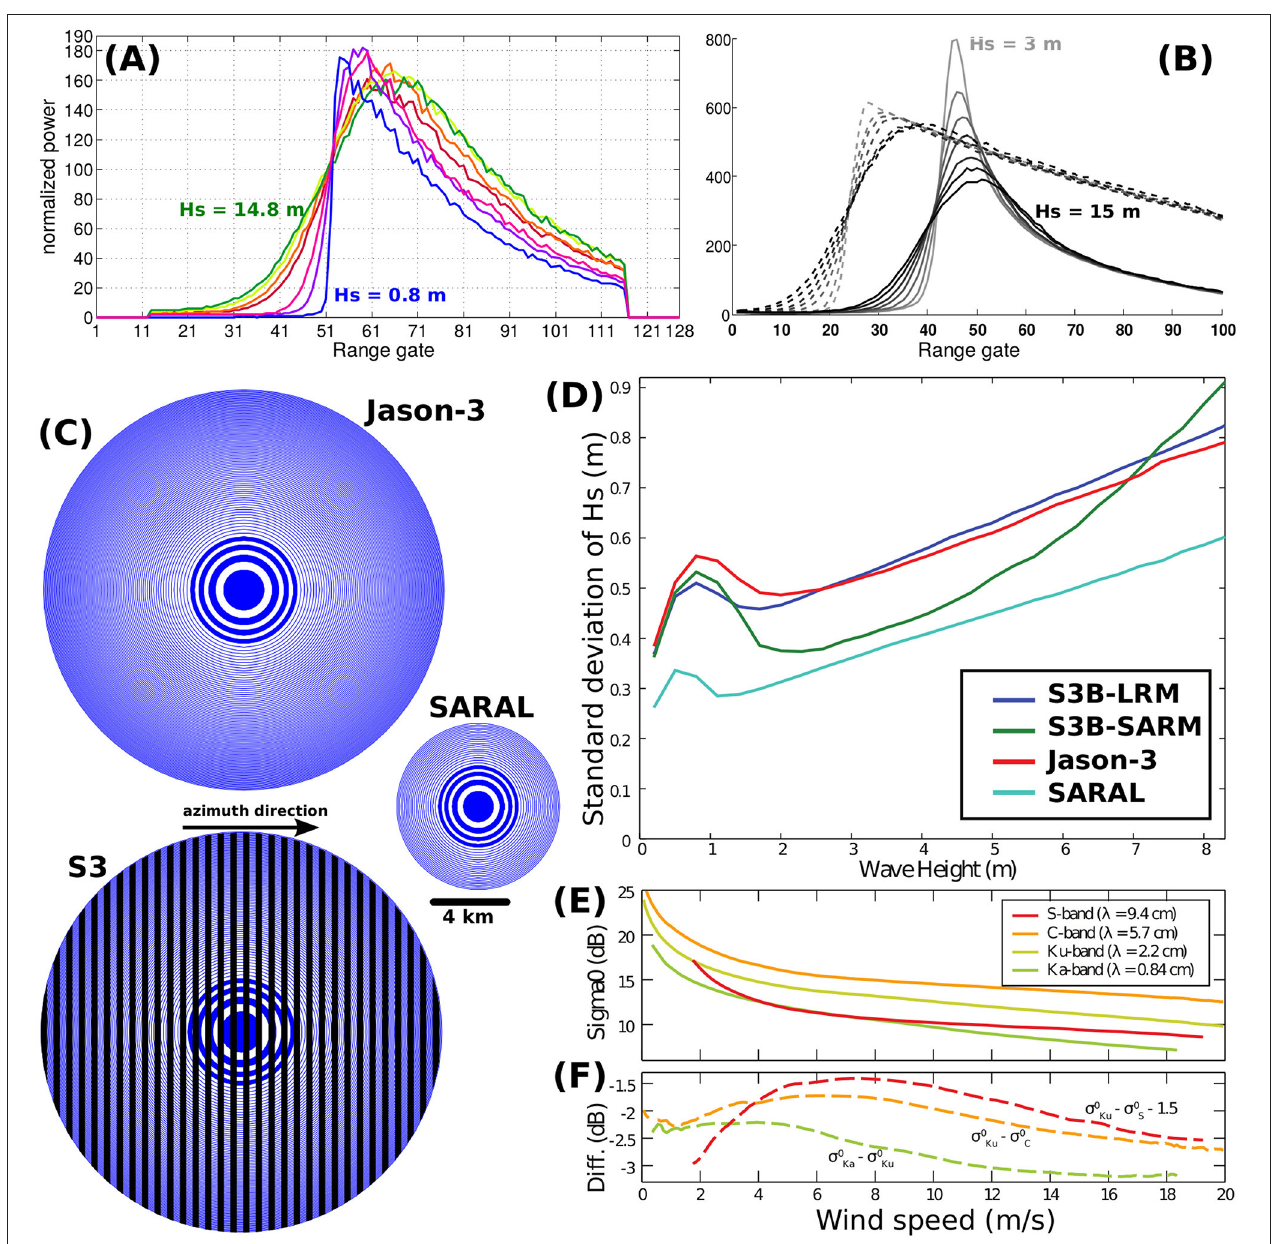
FIGURE 9 | (A) Example of waveforms for a pass along the ascending track of SARAL/AltiKa on February 5, 2014, between 05:29:49 and 06:20:07 UTC. Each waveform shows the power measured by the radar as a function of time: time is discretized with intervals of 2 × 10 − 9 s corresponding to 30 cm range intervals usually called “range gates.” The corresponding wave heights are 0.8, 3.2, 4.6, 9.7, 10.7, 13.2, and 14.8 m. (B) averaged SARM (solid) and LRM (dashed) waveform from Sentinel-3 for H s = 3,5,7,9,11,13 and 15 m, for cycle 23 orbit 349, on 25 October 2017 in the Pacific (C) . Typical size of footprints on the ground for Jason-3, SARAL, and Sentinel-3, as limited by the radar antenna pattern. The rings with alternating blue and white filling, correspond to iso-range lines on a hypothetical flat surface. Only the first few rings are filled for readability. For Sentinel-3 the vertical bands show the azimuth resolution. (D) High-Frequency Noise on H s , computed as Standard Deviation (SD) of high-frequency measurements within a 1-Hz along-track separation, with respect to H s . Data are averaged for a full cycle of Jason-3, SARAL, Sentinel-3B LRM Mode (S-3B LRM, used in 13 days of cycle 10) and Sentinel-3B SAR Mode (S-3B SARM). (E) Backscatter strength ( σ 0 ) as a function of wind speed, and (F) differences for different radar frequencies, adapted from Quartly (2015), as authorized by Taylor & Francis.